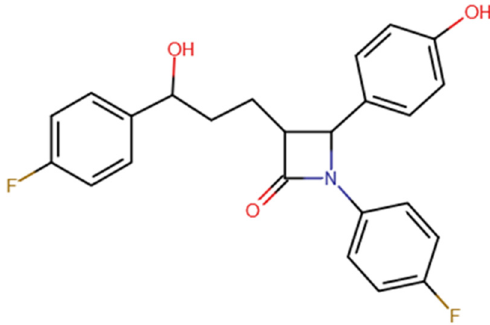
Figure 1. Structure of the ezetimibe molecule.